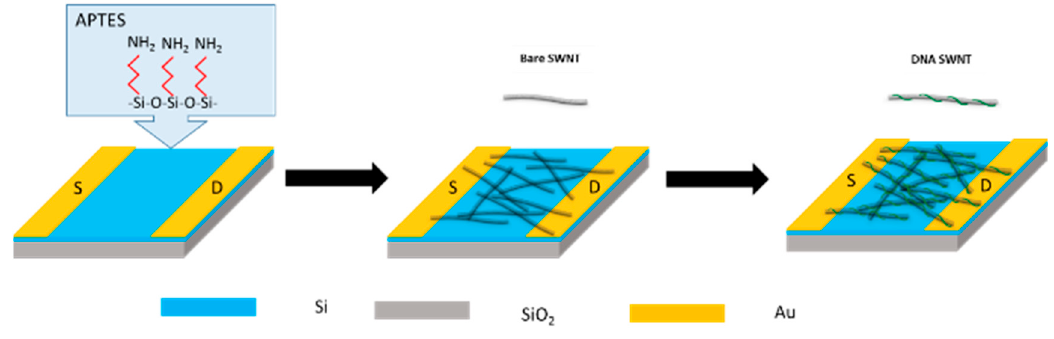
Figure 1. Schematic of single-walled carbon nanotube (SWNT)-wrapped DNA biosensor fabrication.